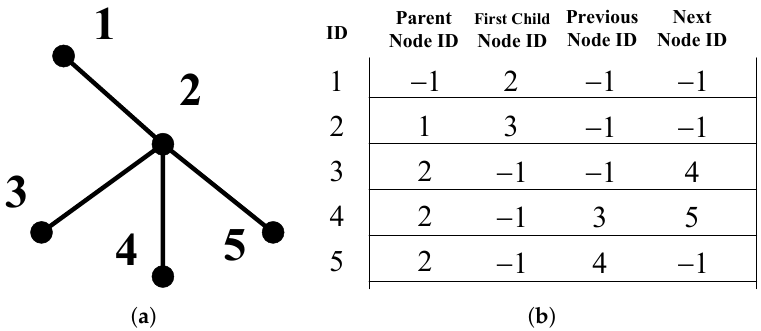
Figure 2. The linked list to describe the tree. ( a ) There are 5 nodes and node 1 is the root node. ( b ) The 5 nodes link list. The row number of the table corresponds to the node id, the four values represent the neighbor node id.